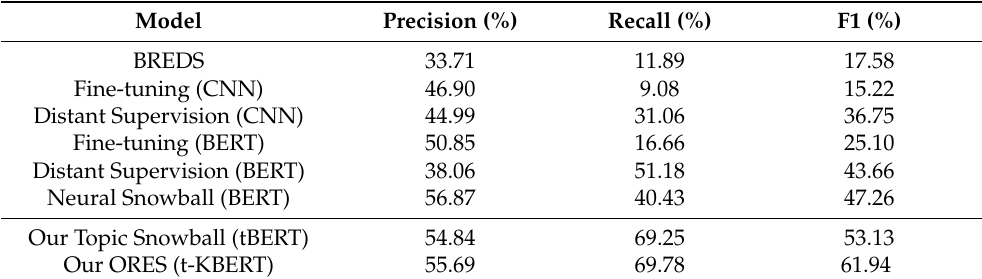
Table 1. The 5-shot experimental results on various previous baseline